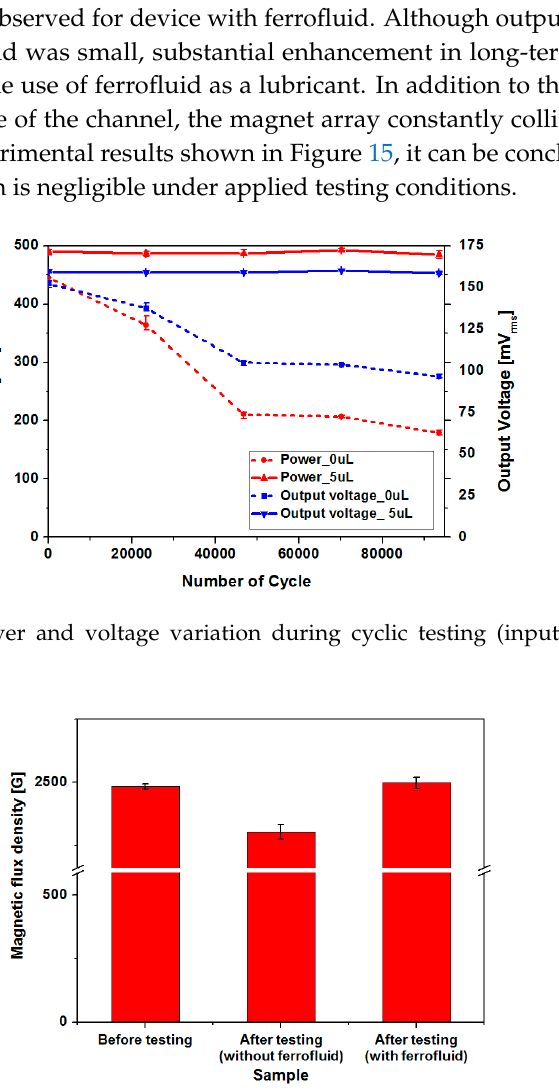
Figure 16. Magnetic flux variation of the permanent magnet before and after cyclic testing.